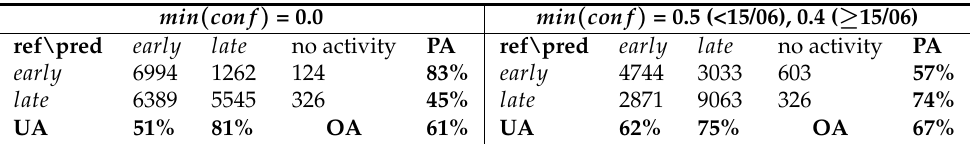
Table 6. Calibration of the minimum mowing detection confidence level ( min ( conf ) ). Confusion matrices crossing the first mowing event classes (before ( early ) or after June 15th ( late )) based on field observations (ref) and mowing detection (pred) for different min ( conf ) of detections. The user and producer accuracies (UA and PA) are provided as well as the overall accuracy (OA). min ( conf ) =